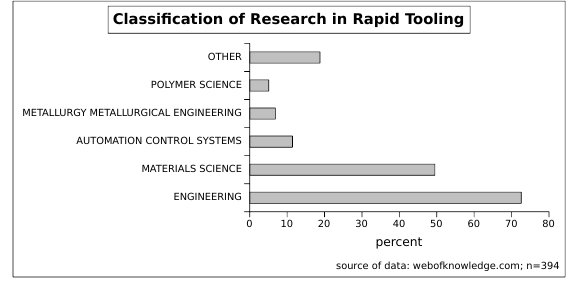
Figure 7. Classification of articles for Rapid Tooling; source of data: